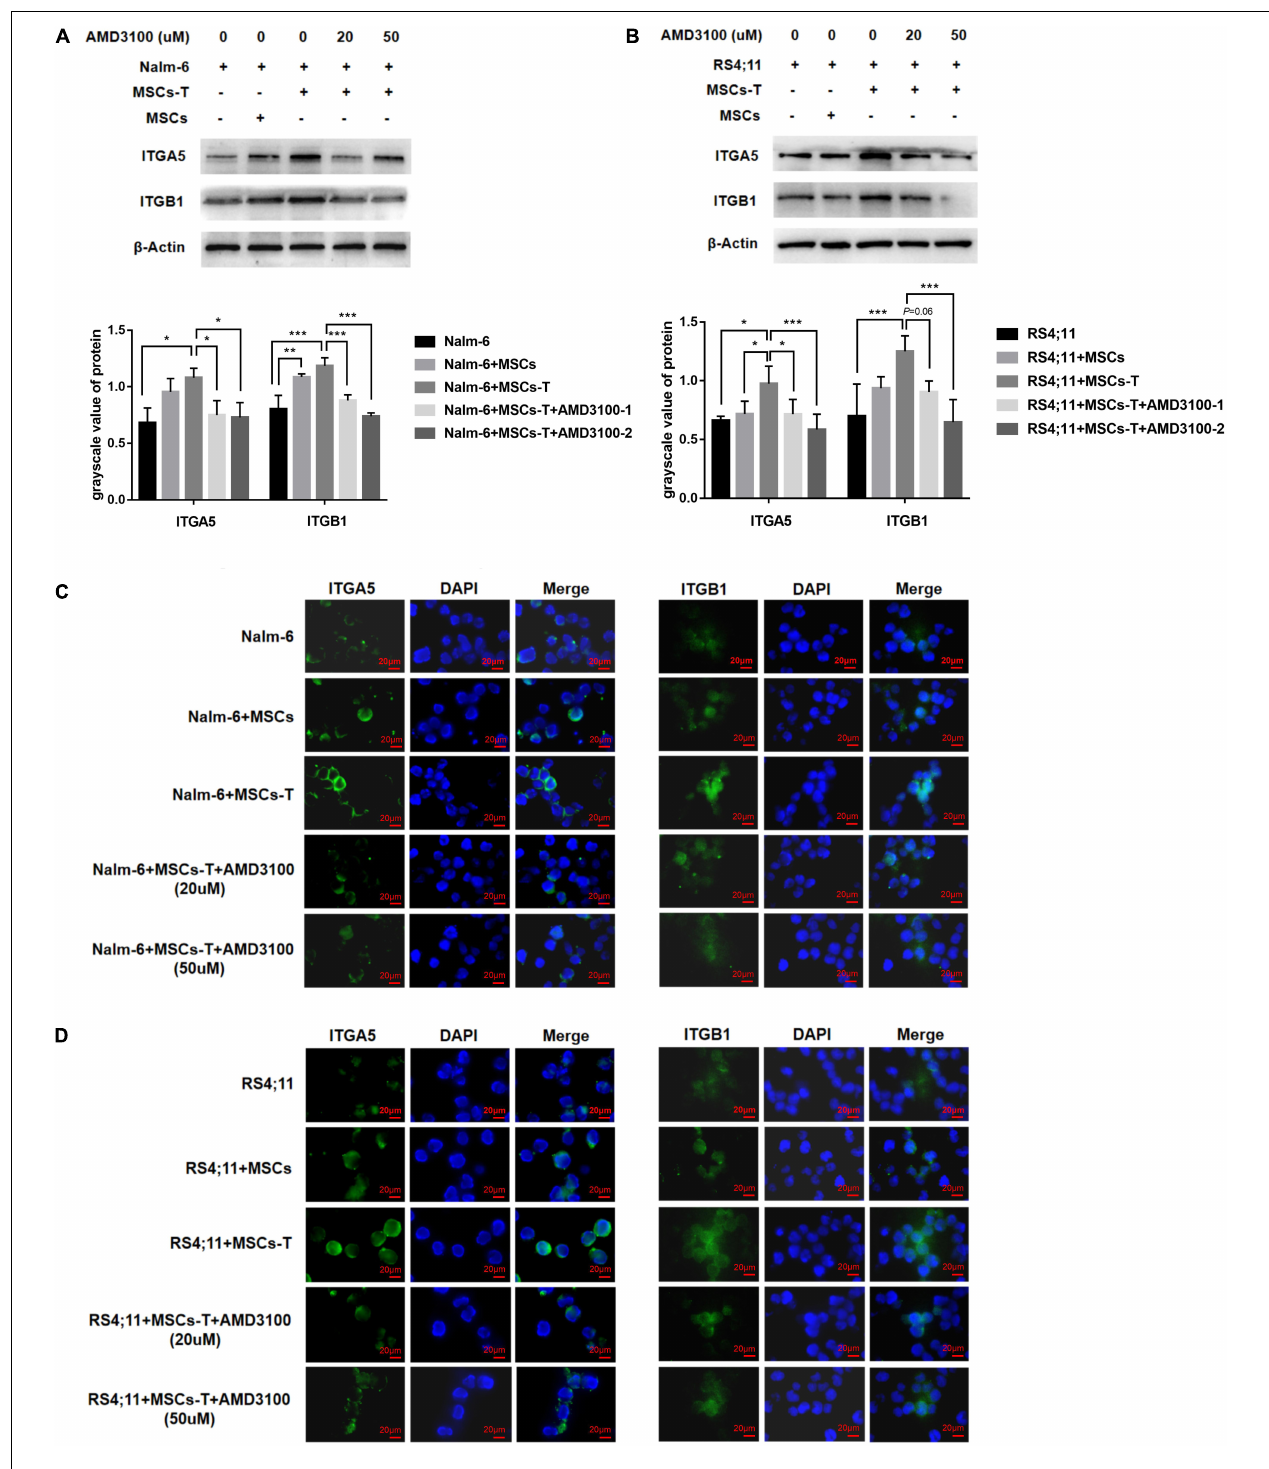
FIGURE 6 | AMD3100 reduced the expression of integrin α 5 β 1 receptors on the surface of leukemia cells. (A,B) The expression of ITGA5 and ITGB1 in the Nalm-6/RS4;11 cells from individual culture and co-culture with MSCs, TGF- β conditioned MSCs, TGF- β conditioned MSCs + AMD3100-1 (20 µ M) and TGF- β conditioned MSCs + AMD3100-2 (50 µ M) for 24 h by western blot. Each value indicates the mean ± SD of three or more independent experiments. In each independent repeated experiment, MSCs was isolated and cultured from a B-ALL patient, and stimulated with rhTGF- β to obtain the CAF-like phenotype, then the latter were compared with the untreated MSCs from the same patient to ensure that the experiment was comparable. * P < 0.05, ** P < 0.01, *** P < 0.001. (C,D) The expression of ITGA5 and ITGB1 in the above five group by IF (1000 × , scale bars, 20 µ m).